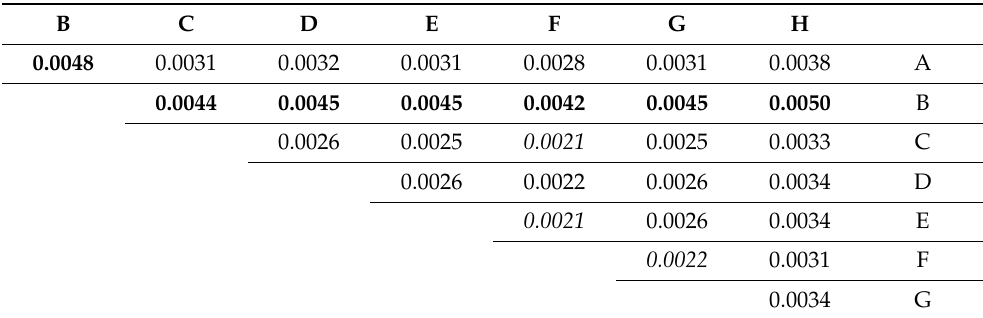
Table 4. u calXY calibration uncertainty values for pairs of metrological appraisers (mm). B C B